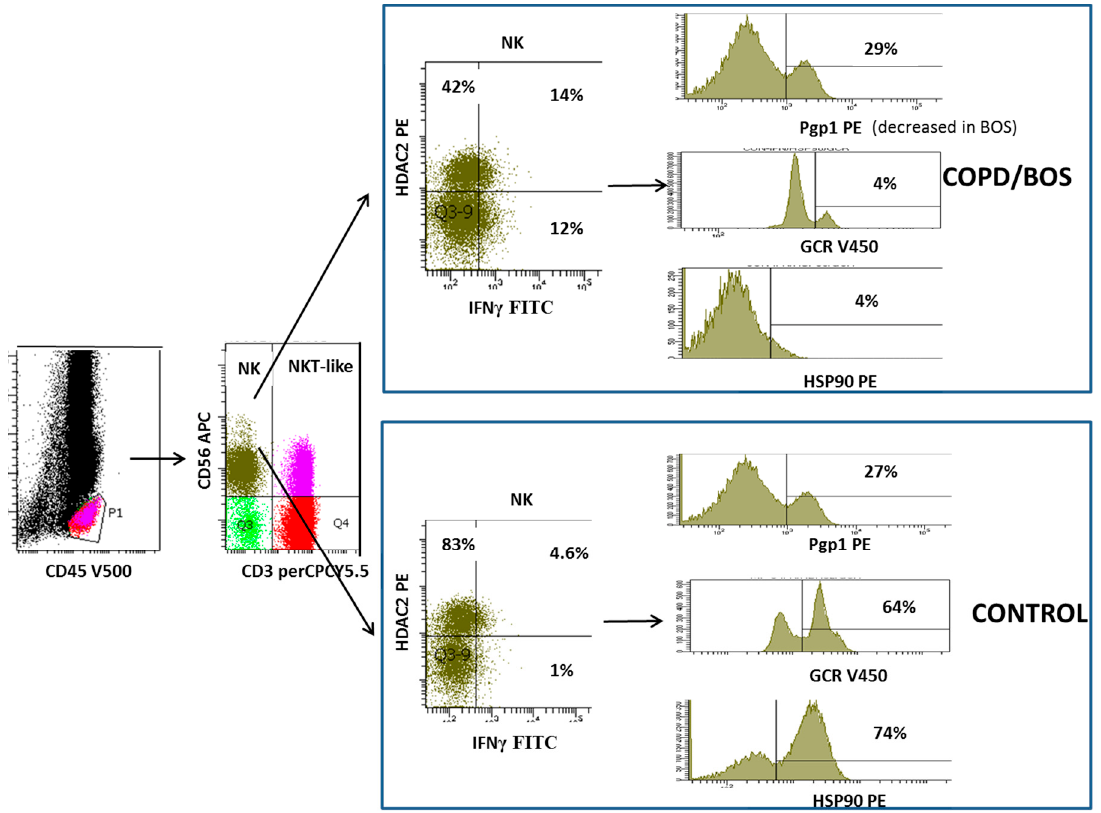
Figure 2. Flow cytometric gating technique used to identify natural killer cell (NK) cells. Identification of lymphocytes as CD45+ low SSC events; Identification of NK cells as CD3-CD56+ events. Expression of IFN γ and HDAC2 in NK cells from COPD and BOS patients compared with controls. Expression of Pgp1, GCR and Hsp90 expression in NK cells from patients with COPD and BOS compared with controls. Note: NK cells express reduced HDAC2, GCR and Hsp90 but increased IFN γ in patients with COPD and BOS compared with controls. Pgp1 expression was unchanged in patients with COPD but decreased in patients with BOS compared with control subjects (not shown) suggesting alternate mechanisms of steroid resistance in these patients.